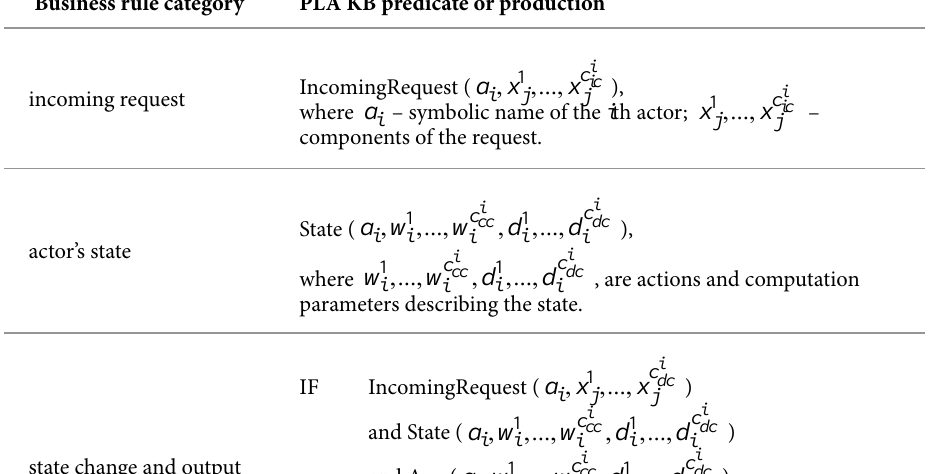
business rule category PLA kb predicate or production